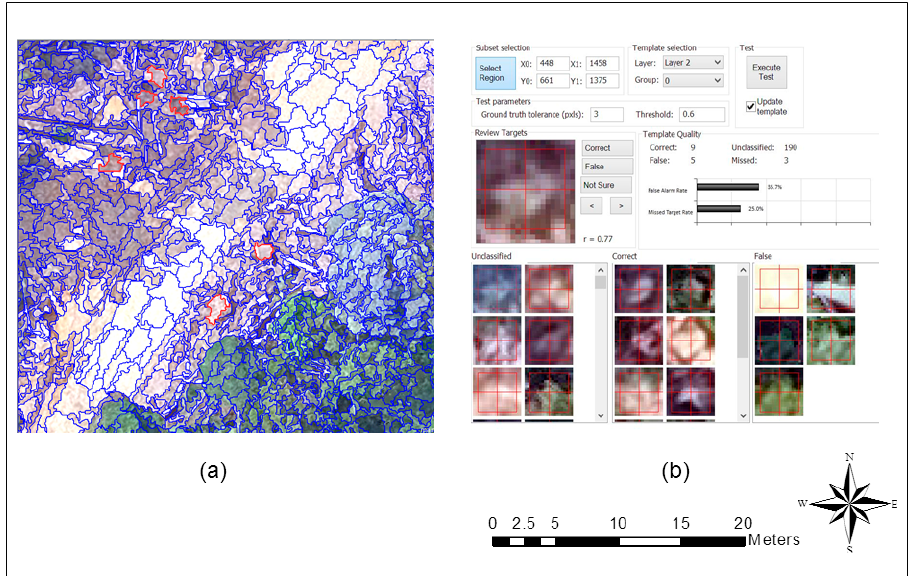
Figure 6. Methods of integrating OBIA and TM. ( a ) Detail of scale in OBIA; ( b ) sample of TM search- ing.